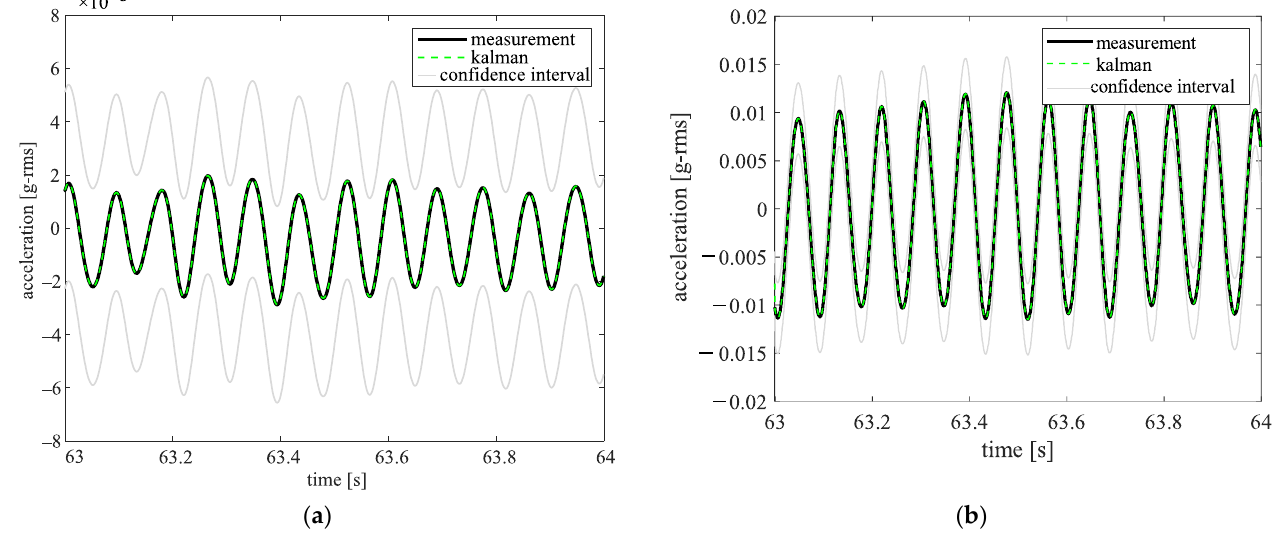
Figure 18. Kalman filter for prediction and validation, brg3- as prediction, calculated response at bearing 1 ( a ) bearing 1-y, ( b ) bearing 1-z. for estimation of the acceleration for test-a. ( a ) brg1-y, ( b ) brg 1-z.